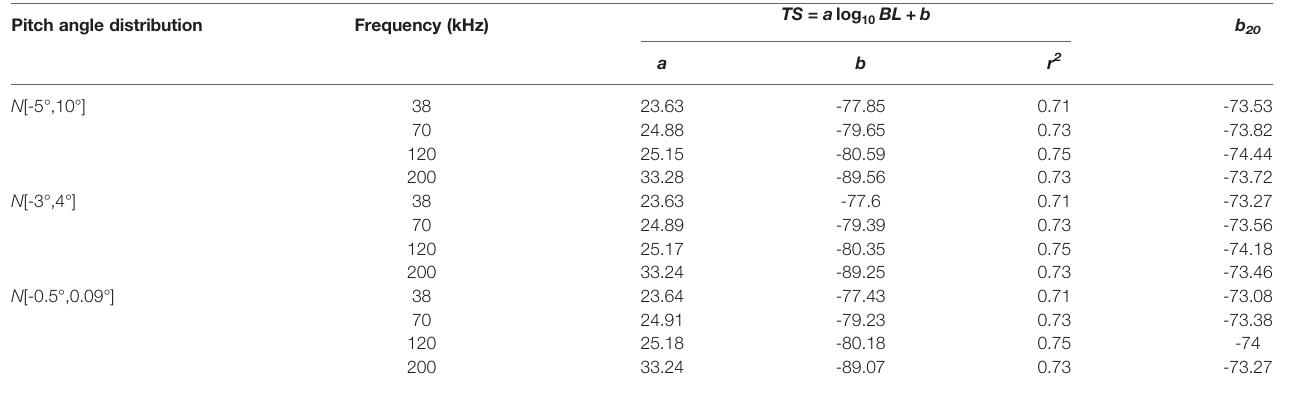
TABLE 3 | Equations of the linear regressions plotted in Figure 5